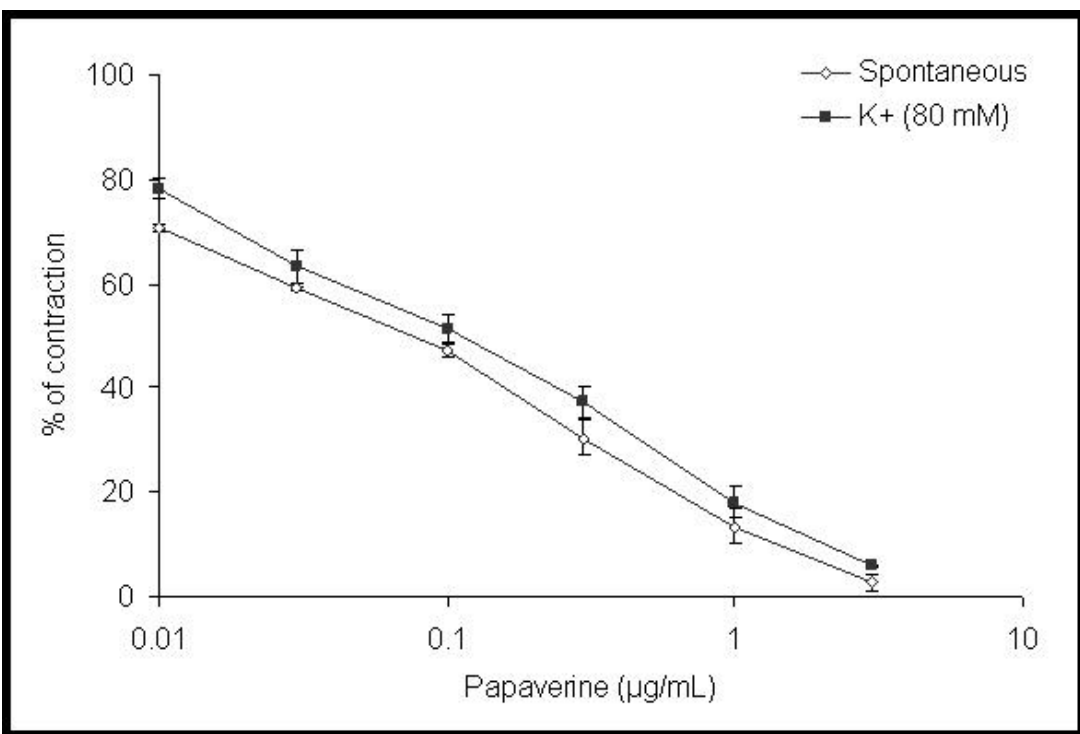
Figure 2. Inhibitory effect of papaverine on spontaneous and high K + -induced contractions in isolated rat ileum.